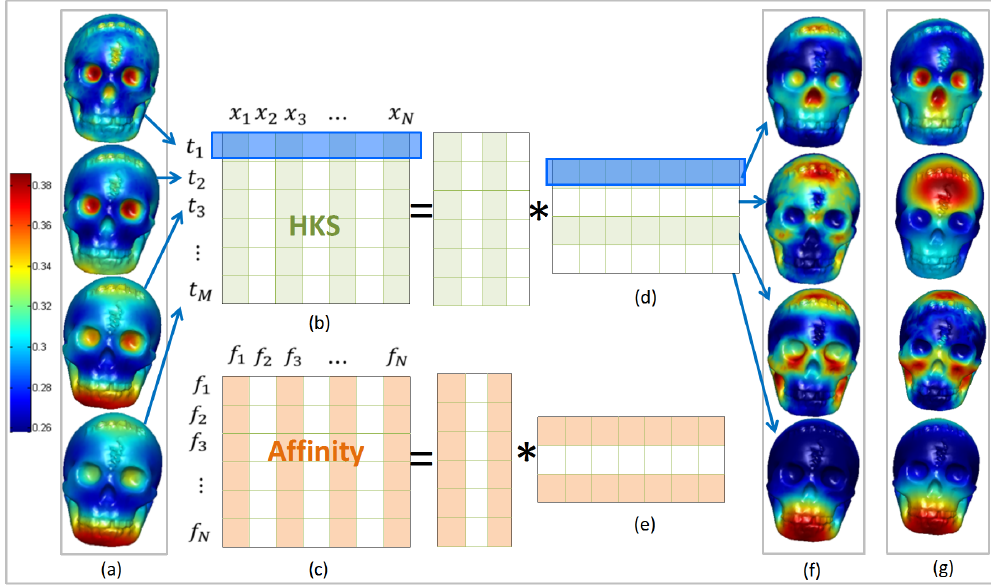
Figure 3. The feature matrices constructed on three-dimensional (3D) model based on ( b ) Heat Kernel Signatures (HKSs) descriptors and ( c ) graph affinity. ( a ) illustrates the visible variables (HKSs with different time scales) on the skull models, ( d , e ) denote the matrixes consisting of hidden variables, ( f , g ) illustrate the hidden variables obtained via standard NMF and Sparse and Constrained Non-negative Matrix Factorization